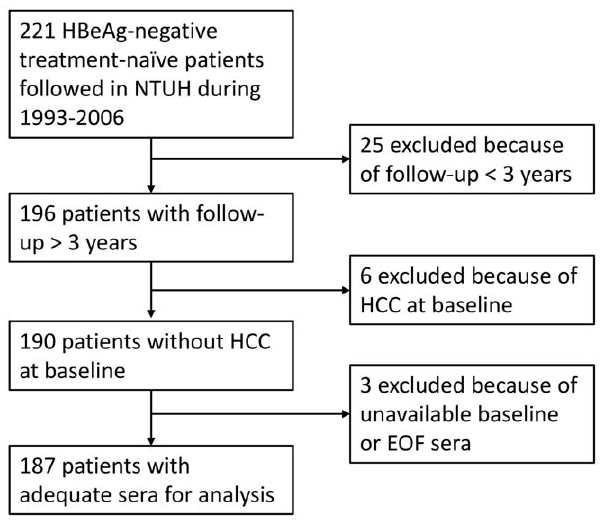
Figure 1. The flow chart of patient enrollment. EOF=end-of- follow-up, HCC=hepatocellular